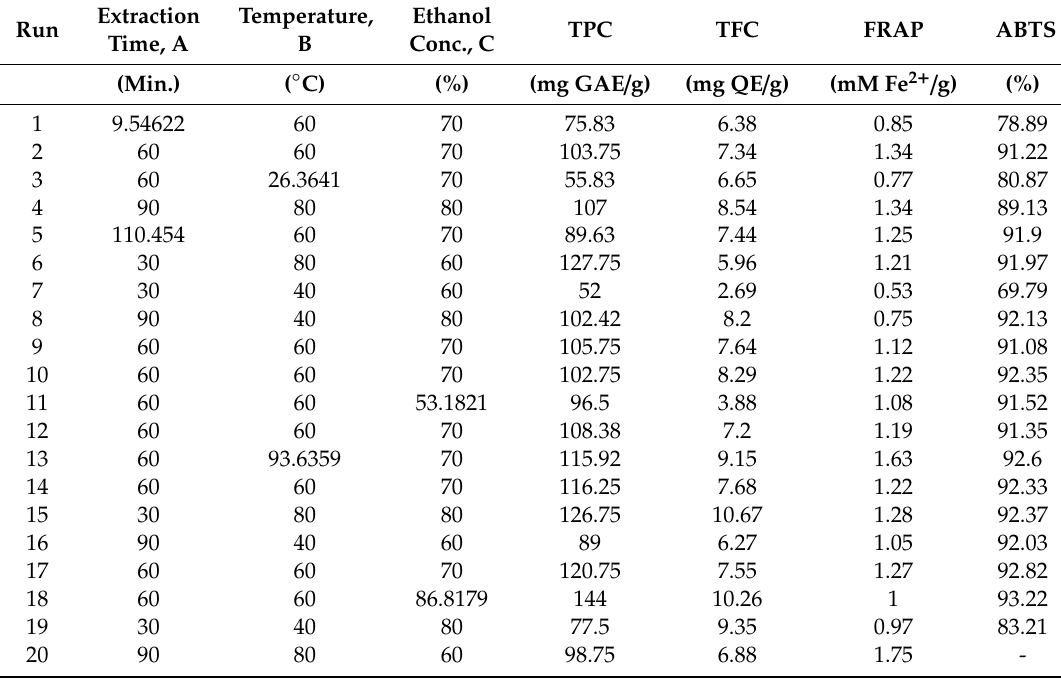
Table 5. Experimental design with observed responses of total phenolic content (TPC), total flavonoid content (TFC), and ferric reducing antioxidant power (FRAP) from defatted pitaya seed